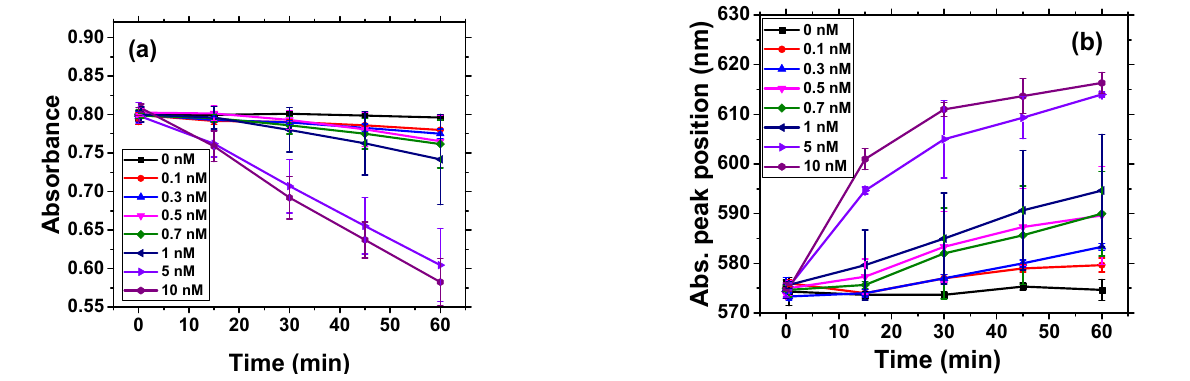
Figure 5. Changes in the absorbance ( a ) and in maximum position of absorbance peak ( b ) vs. time for different chymotrypsin concentrations in a suspension of AuNPs modified by β -casein and MCH. The results represent mean ± SD obtained from 3 independent measurements at each concentration of chymotrypsin.